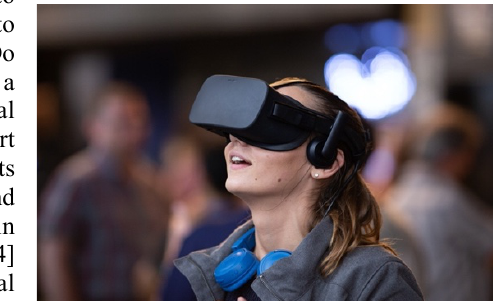
Figure 2 . Engagement at cultural